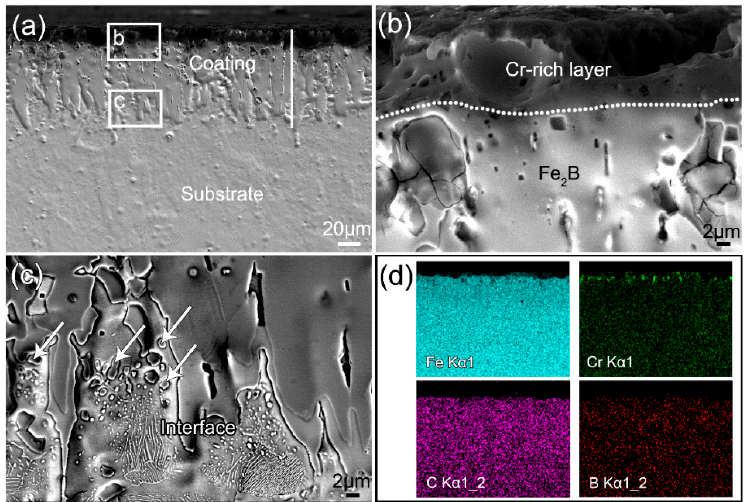
Figure 4. Microstructure and elements distribution after the BC-1 treatment: ( a ) sectional SEI view of the coating; ( b , c ) high-magnification SEI and BSEI images corresponding to the white boxes; ( d ) the EDS mapping corresponds to the entire area in ( a ).